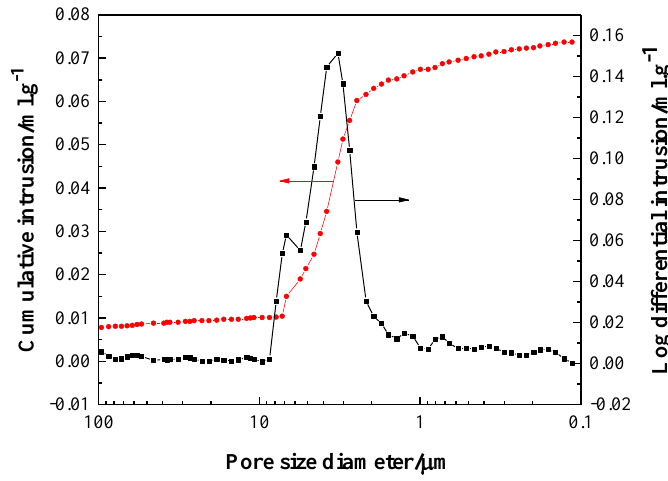
Figure 10. Pore size distribution of the TiAl alloy sintered at 1400 °C in vacuum for 2 h.